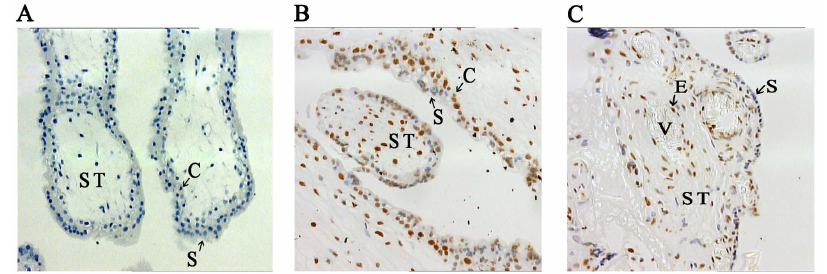
Figure 4. 5-Methylcytidine (5-mC) immunostaining of placental samples. Tissue sections from paraffin-embedded placental tissues were treated with primary (Mouse anti 5-mC, concentration: 1/800), secondary (horse anti-mouse, concentration: 1/400) antibodies. Color development was performed with immunoperoxidase system. The 5-Methylcytidin-positive cells were stained brown, while negative cells displayed blue color of hematoxylin counterstaining. A . The negative control (1N) (20 6 10 magnitude) without primary antibody. B . 5-mC immunostaining of 1N placenta (20 6 10 magnitude). C . 5-mC immunostaining of 3N placenta (20 6 10 magnitude). Compared to 1N placenta, thinner lay of syncytium was observed in 3N placenta. Syncytiotrophoblasts (S) were stained relatively lighter than cytotrophoblast (C), stromal cells (ST), and epithelial (E) cells. V, blood vessels. Overall, similar intensity of 5-mC staining was observed 1N and 3N placentas.